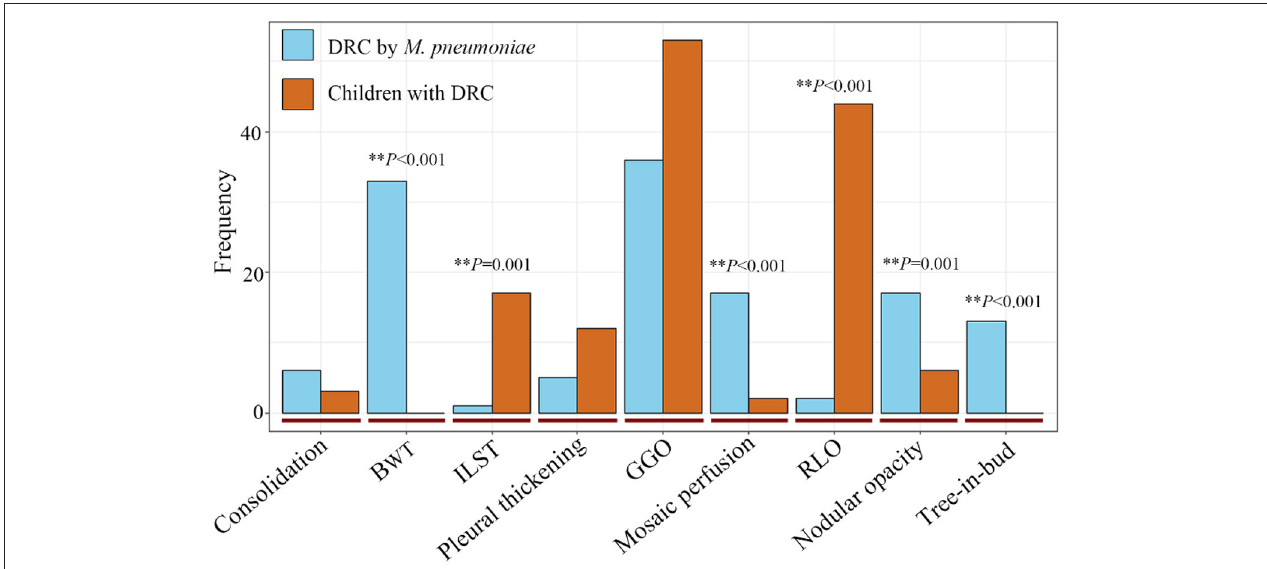
FIGURE 2 | HRCT features of diffuse radiological changes (DRC) in children older than 2 years. Among children with DRC, ground glass opacity and reticular & linear opacities were most frequently identified imaging findings, followed by interlobular septal thickening and pleural thickening. They had no tree-in-bud pattern and bronchial wall thickening. Notably, children with DRC caused by M. pneumoniae infections showed a different pattern. In addition to ground glass opacity, they presented with bronchial wall thickening, mosaic perfusion, and tree-in-bud. BWT, bronchial wall thickening; ILST, interlobular septal thickening; GGO, ground glass opacity; RLO, reticular and linear opacities. ** P < 0.01.